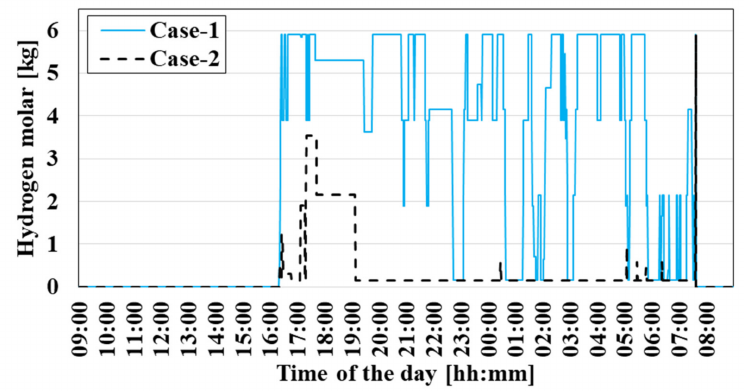
Figure 11. Variation in hydrogen molar at hydrogen tank of FCEV18 in Case-1 and